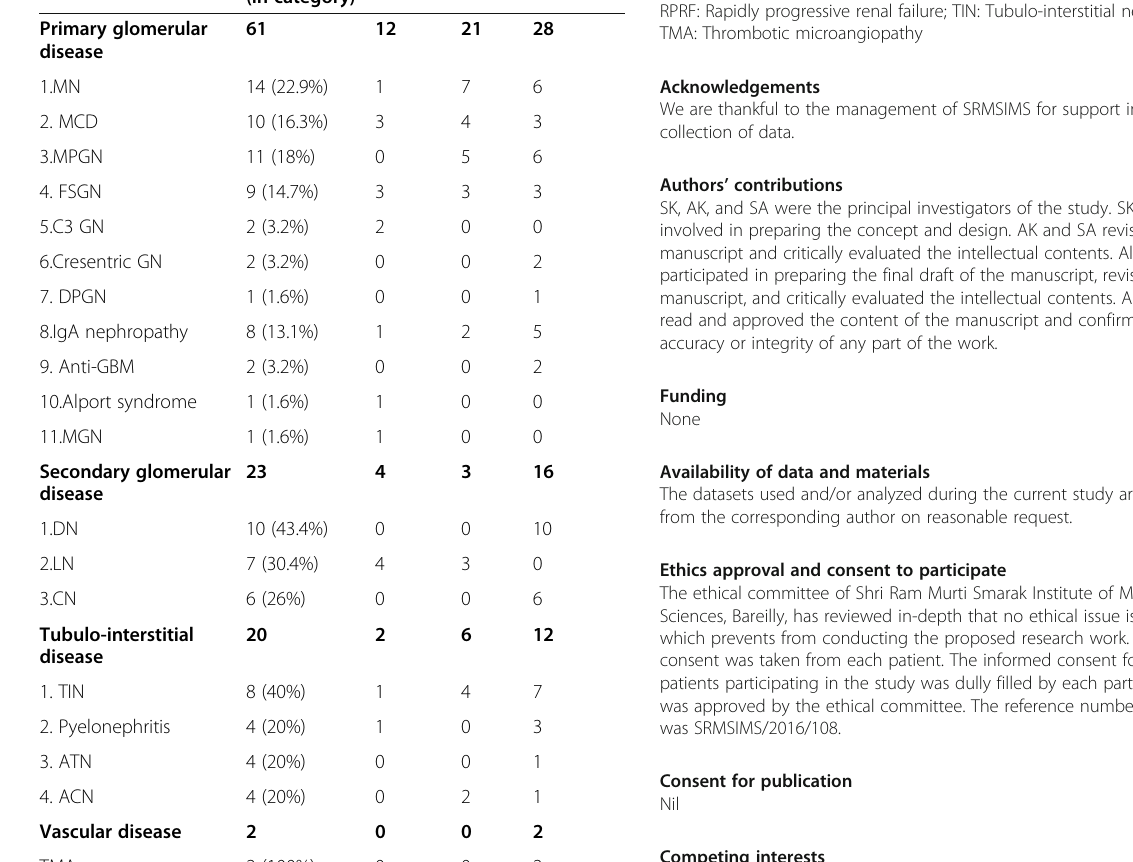
Table 4 Histopathological findings among various age groups Renal disease Number of patients with percentage (in category) Primary glomerular